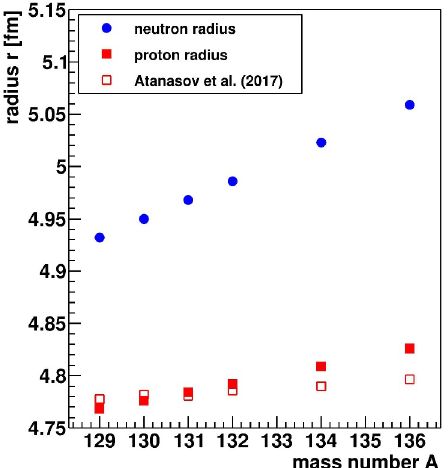
Figure 3. Red points show the double ratio pre- dicted by the full GiBUU simulations for isotopes pairs of A Xe and 129 Xe. For comparison, the blue squares are the results of Eq. (9), adopting the same proton and neutron radii as shown in Fig.